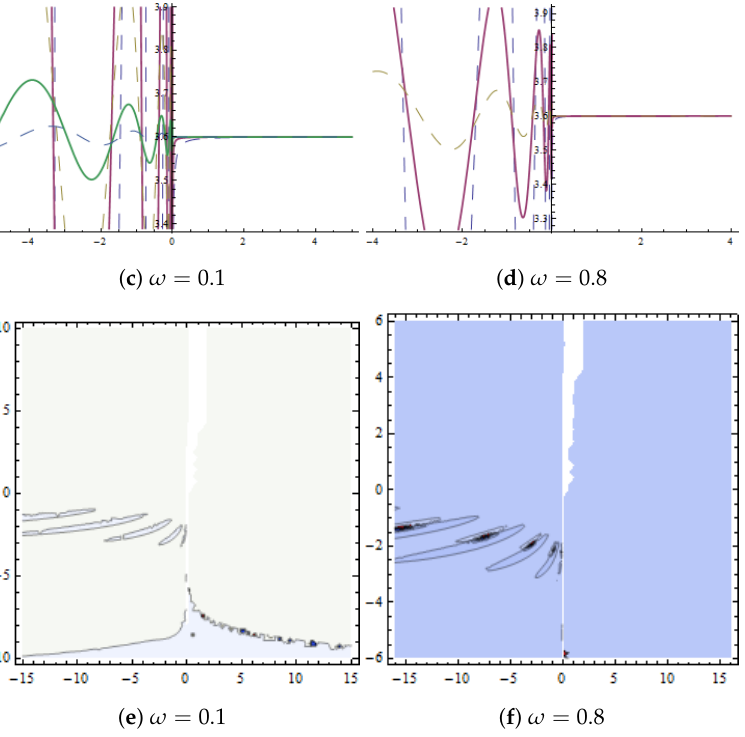
Figure 23. ( a , b ) show 3D graphs and ( c , d ) represent 2D graph. Dynamical presentation of solution v ( x , t ) in Equation (57) with β 1 = 0.3, β 2 = 1.2, β 3 = 0.5, ζ = 0, l 1 = − 1.8, l 2 = 0.05, l 4 = 0.01, Q = 5.2, r 1 = 2.5, r 2 = 1.3, w 2 = 0.1, w 3 = 3, w 4 = 1.9, w 5 = 1.2 and φ = 1.4. ( e , f ) show contour plot.